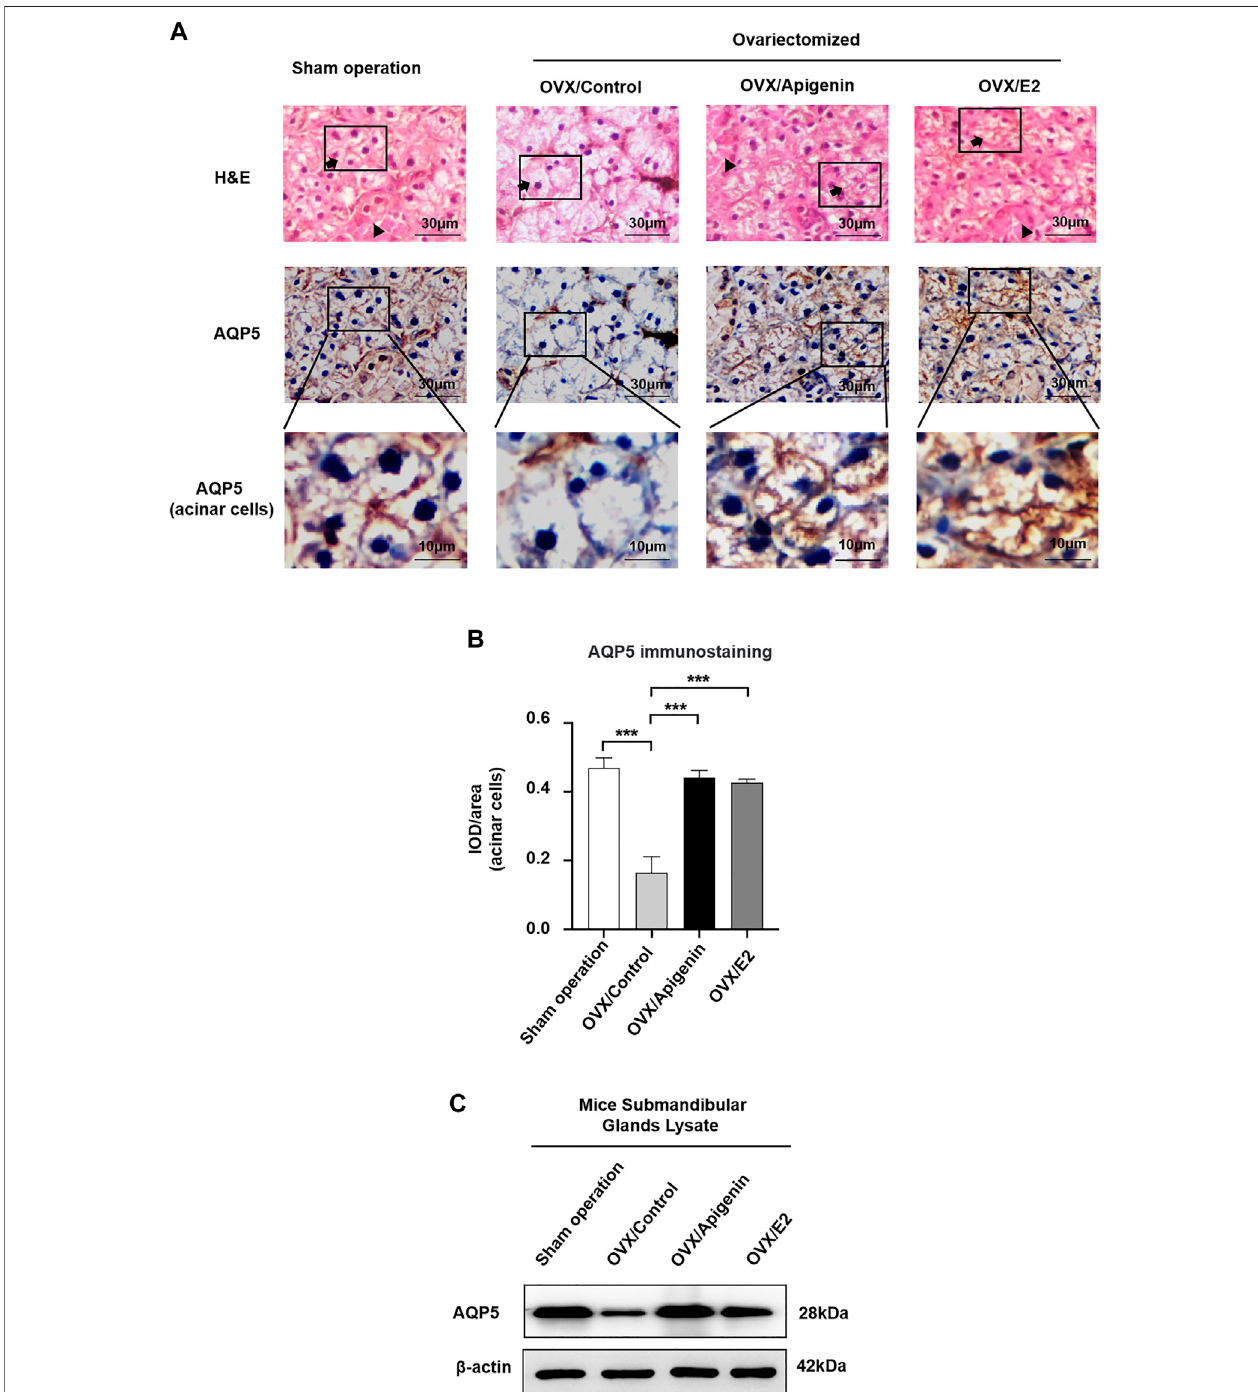
FIGURE 7 | Apigenin treatment upregulates AQP5 expression in the submandibular gland of OVX mice. (A) Histological images (H&E stained) and immunohistochemistry images of AQP5 of mice submandibular gland tissues. Arrows, acinar cells. Triangles, ducts cells. (B) Quantitative analysis of immunohistochemistry images. (C) AQP5protein expression inthesubmandibularglandlysate. Dataarepresented asthemean ±SD, n =6mice per group. Signi fi cant effect of the treatment, * p < 0.05, ** p < 0.01.